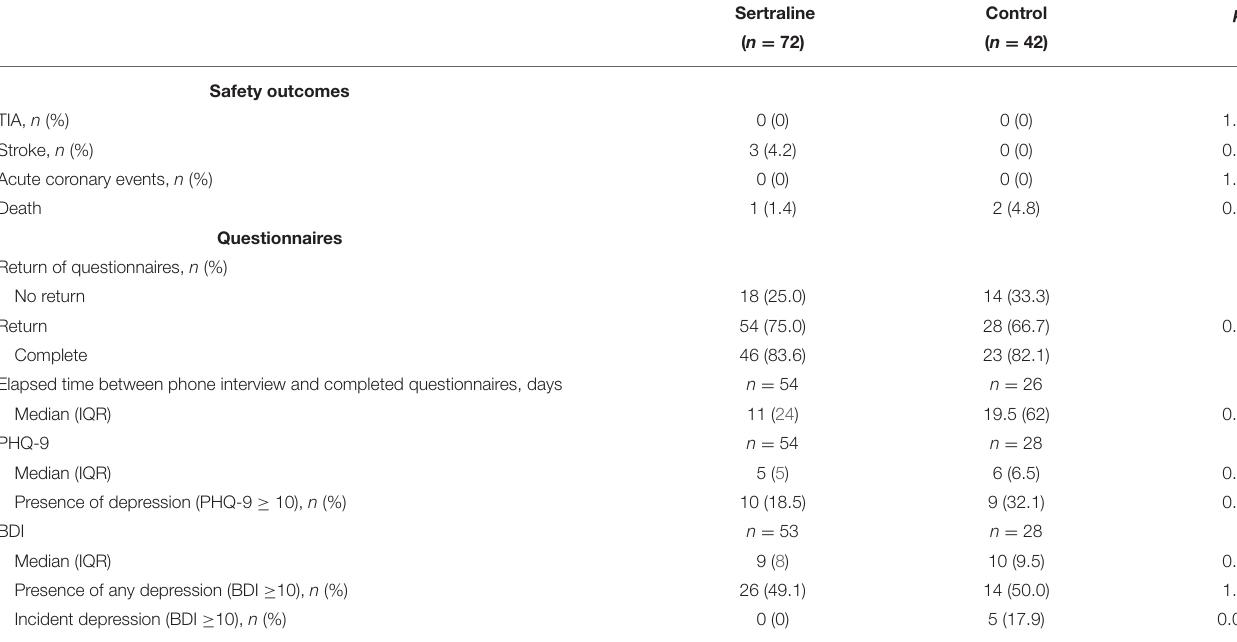
TABLE 3 | Secondary patient outcomes at 3